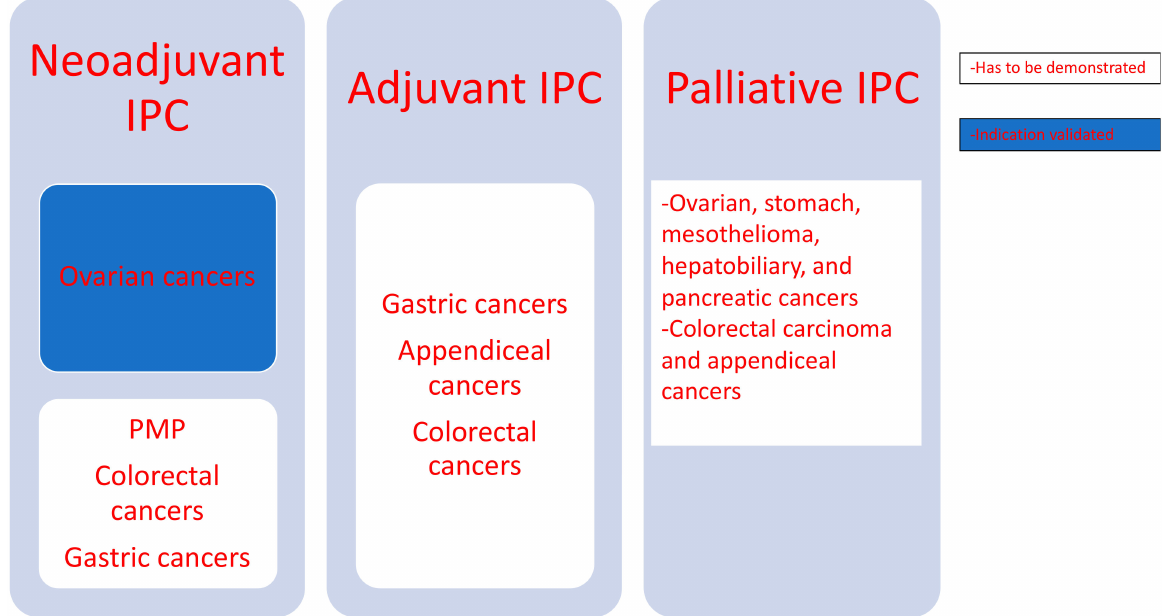
Figure 2. Different indications neoadjuvant, adjuvant and palliative of intraperitoneal chemotherapy. PMP: peritoneal